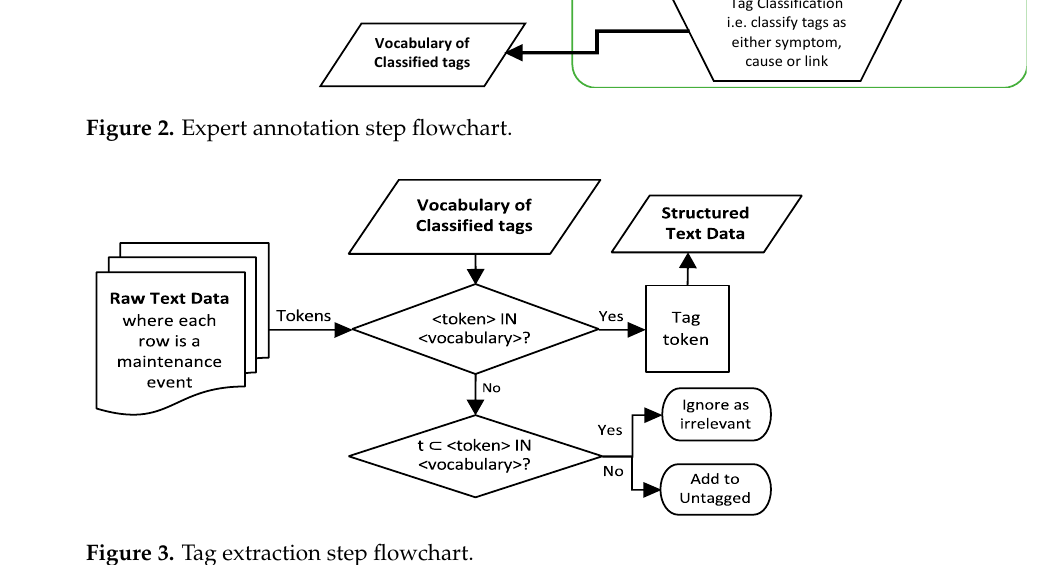
Figure 3. Tag extraction step flowchart.